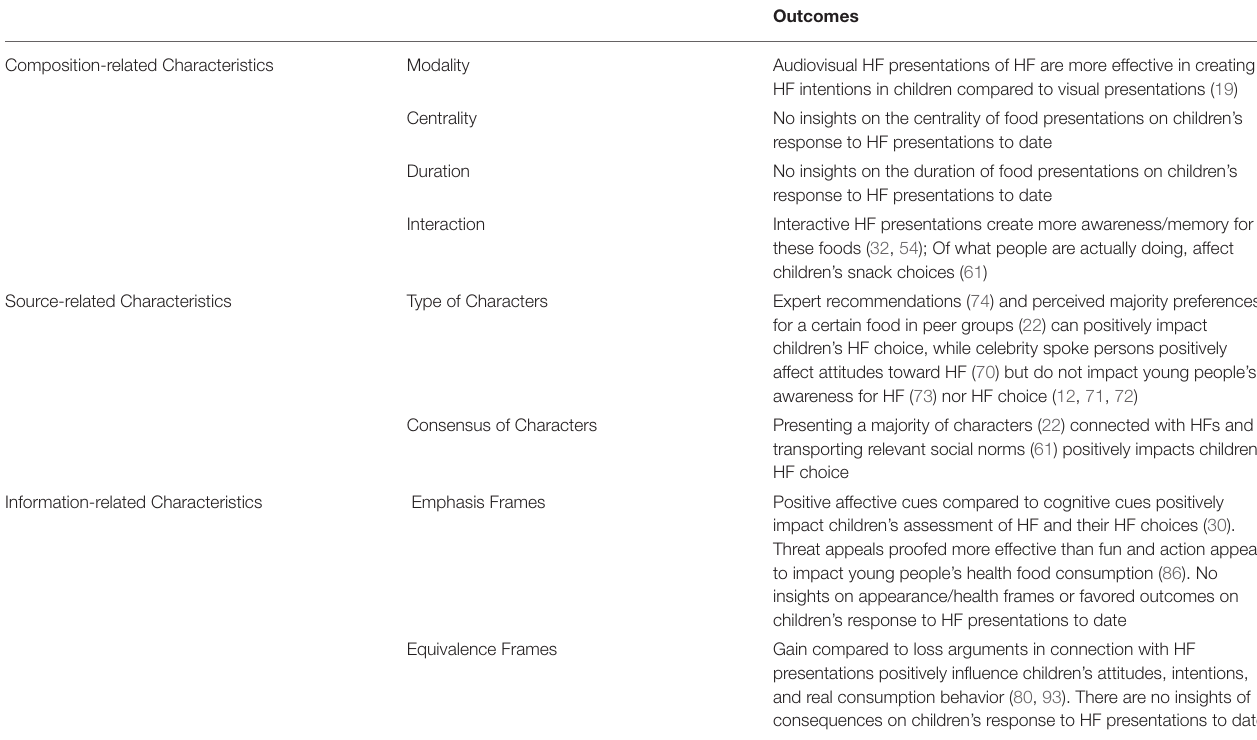
TABLE 2 | Overview of Evidence on the Persuasive Strategies Regarding the Effects of Healthy Foods (HF) on